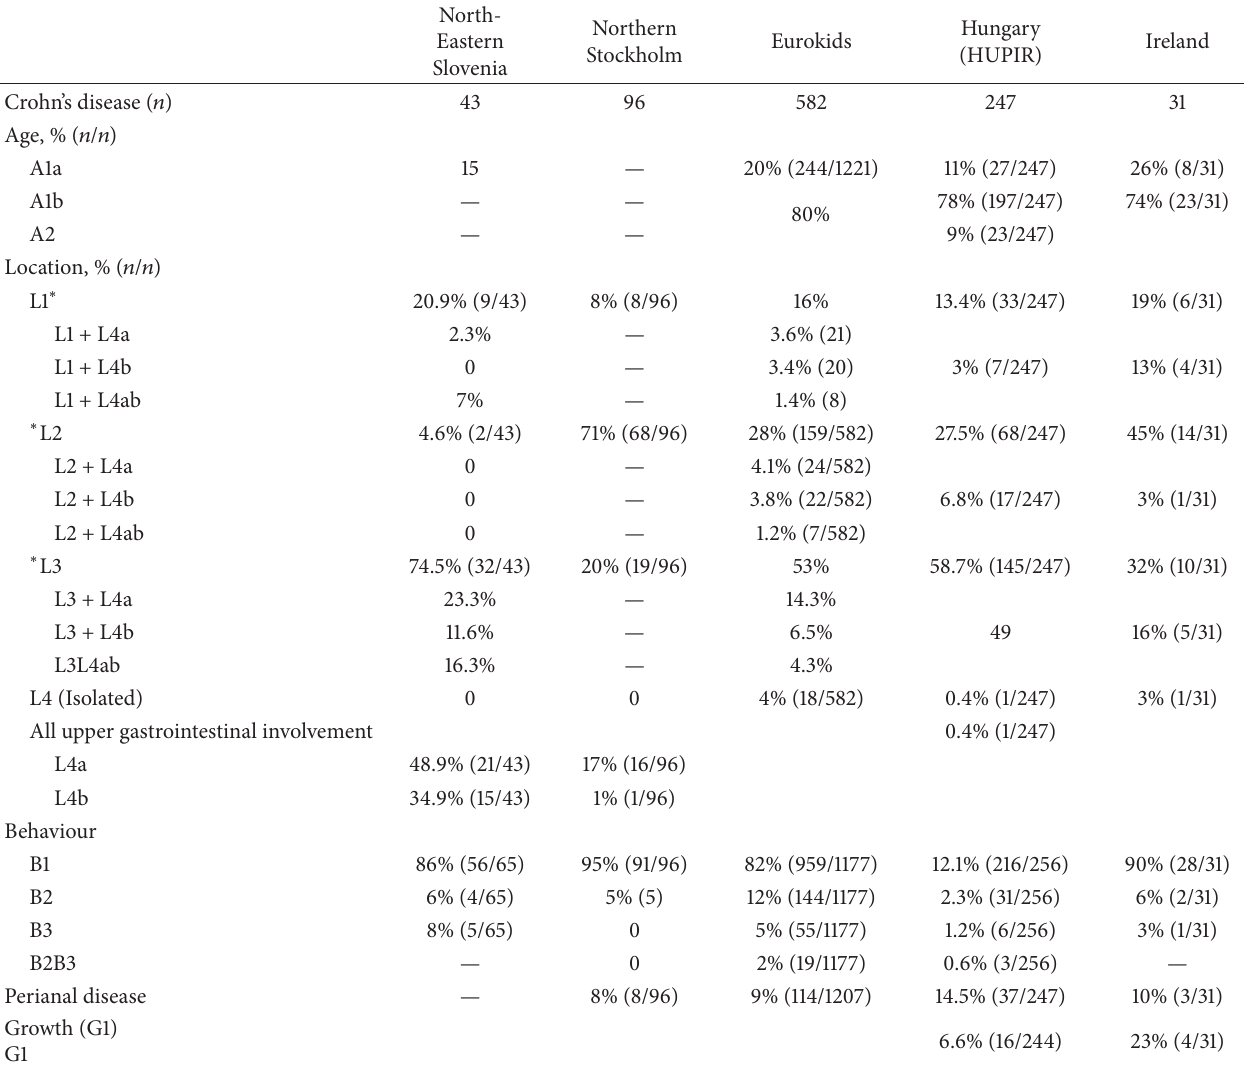
Table 4: Paris Classification of patients with Crohn’s disease in population-based studies in Europe [3, 32, 34, 57,